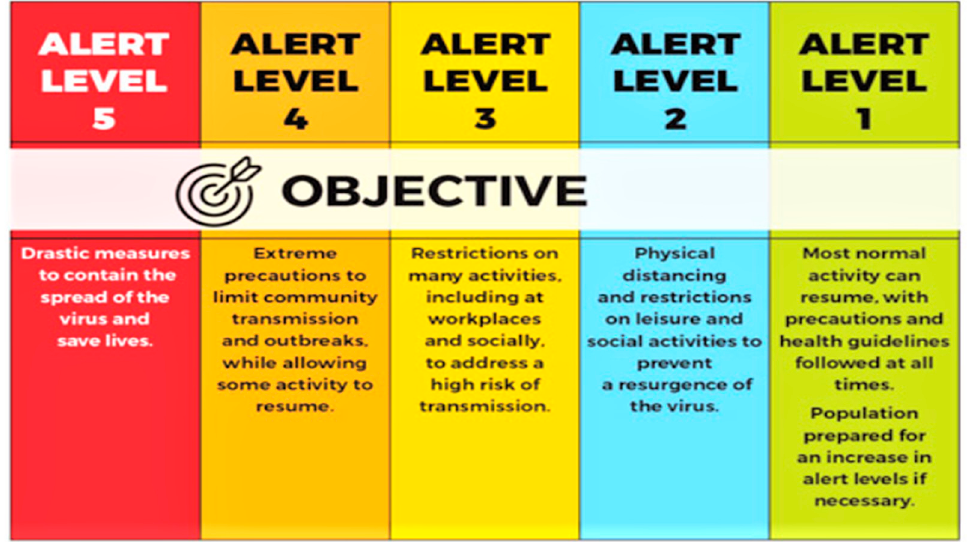
Figure 1. Summary of alert levels.